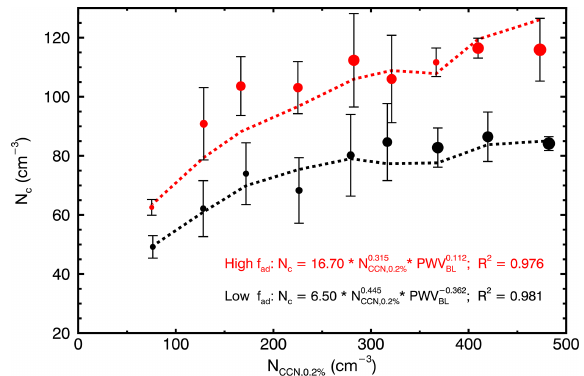
Figure 6. N c as a function of N CCN , 0 . 2% ( x axis) and PWV (dots) for high-adiabaticity (high- f ad ) (red) and low- f ad (black) regimes. The larger circles represent higher PWV values. Whiskers denote 1 standard deviation for each